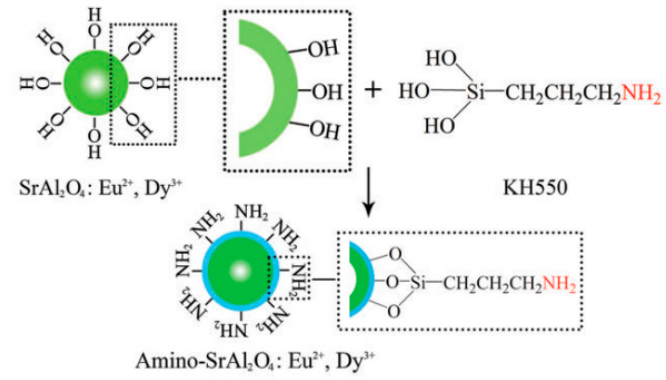
Figure 8. Synthesis route and molecular structure of Amino-SrAl 2 O 4 :Eu 2+ ,Dy 3+ [66].